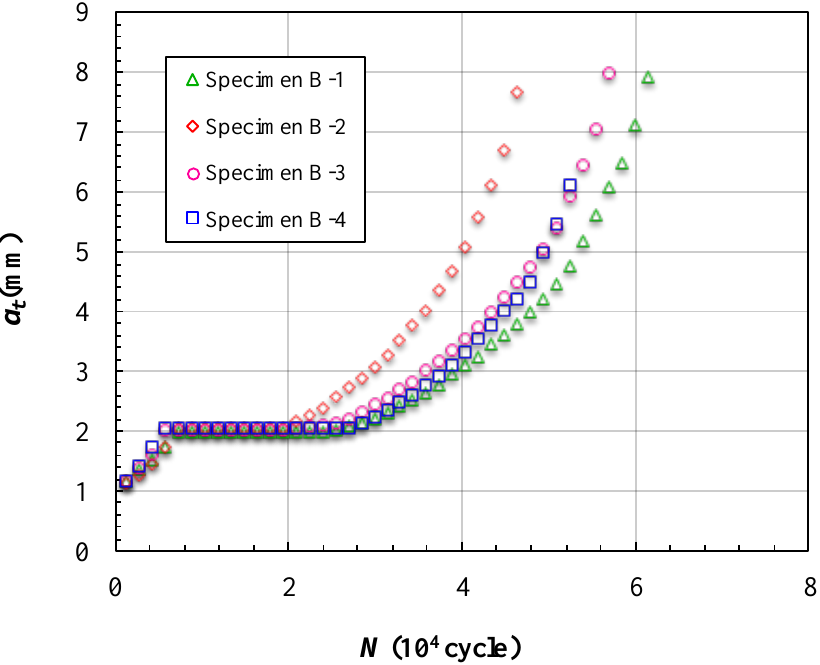
Figure 15. FCG rate at different crack lengths a w of specimens of Group B.